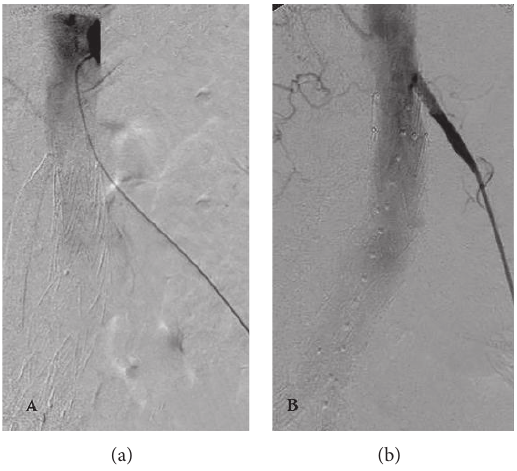
Figure 5: Retrograde cannulation of the left renal artery with a 4 Fr JR catheter; injection of contrast medium through the catheter confirming the successful reentering into the aorta (a). Completion angiogram after retrograde bare metal stent placement confirming patency of the renal artery (b).